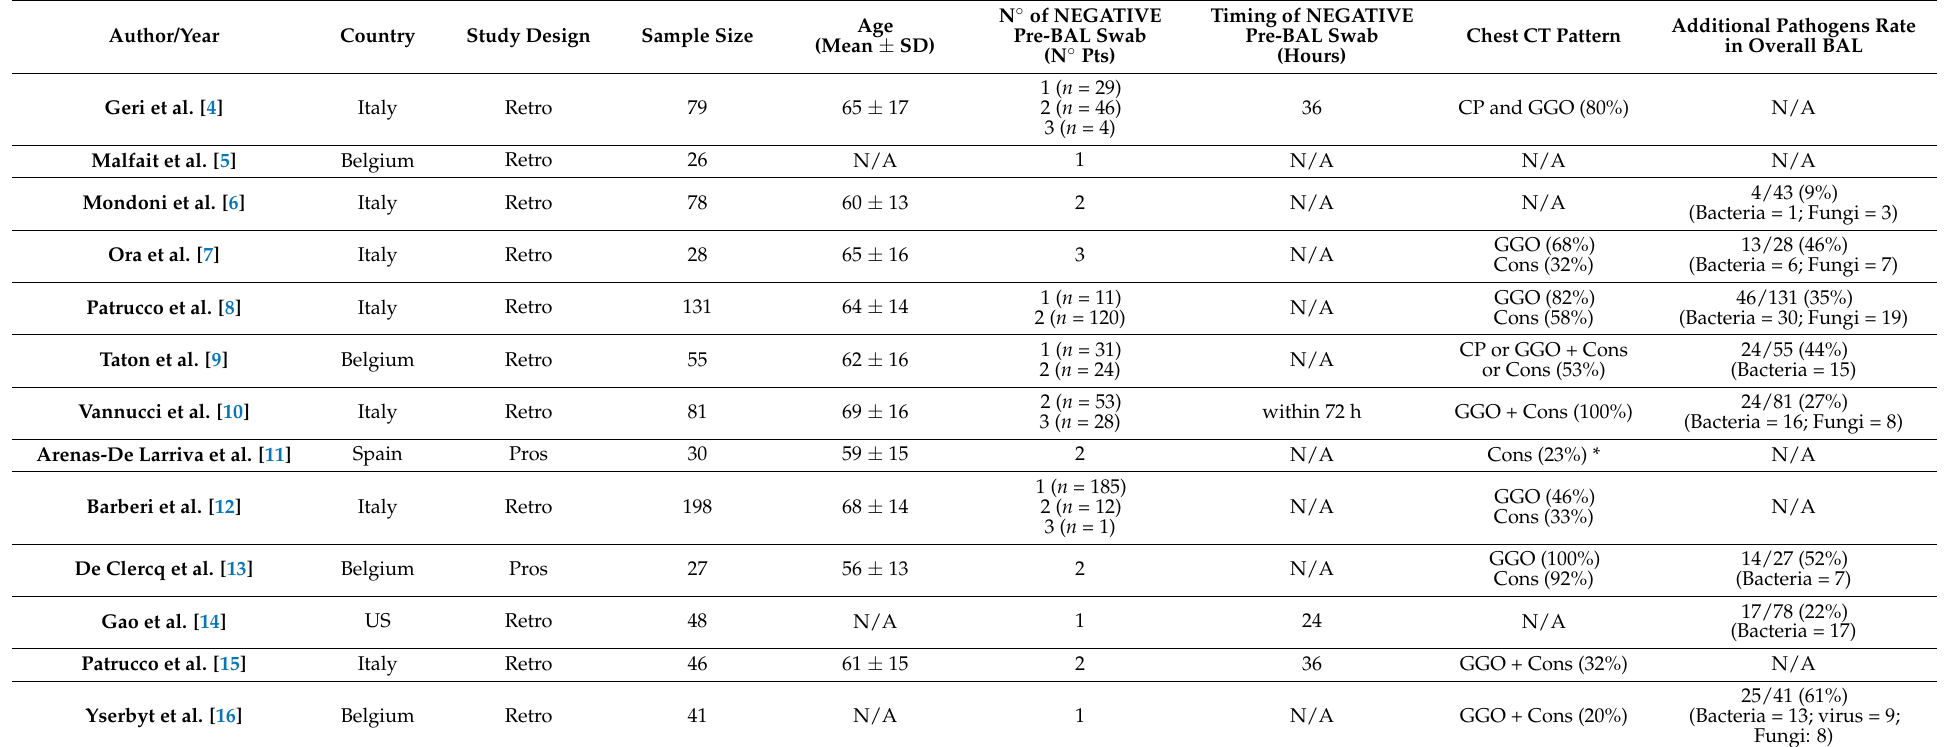
Table 1. Characteristics of included